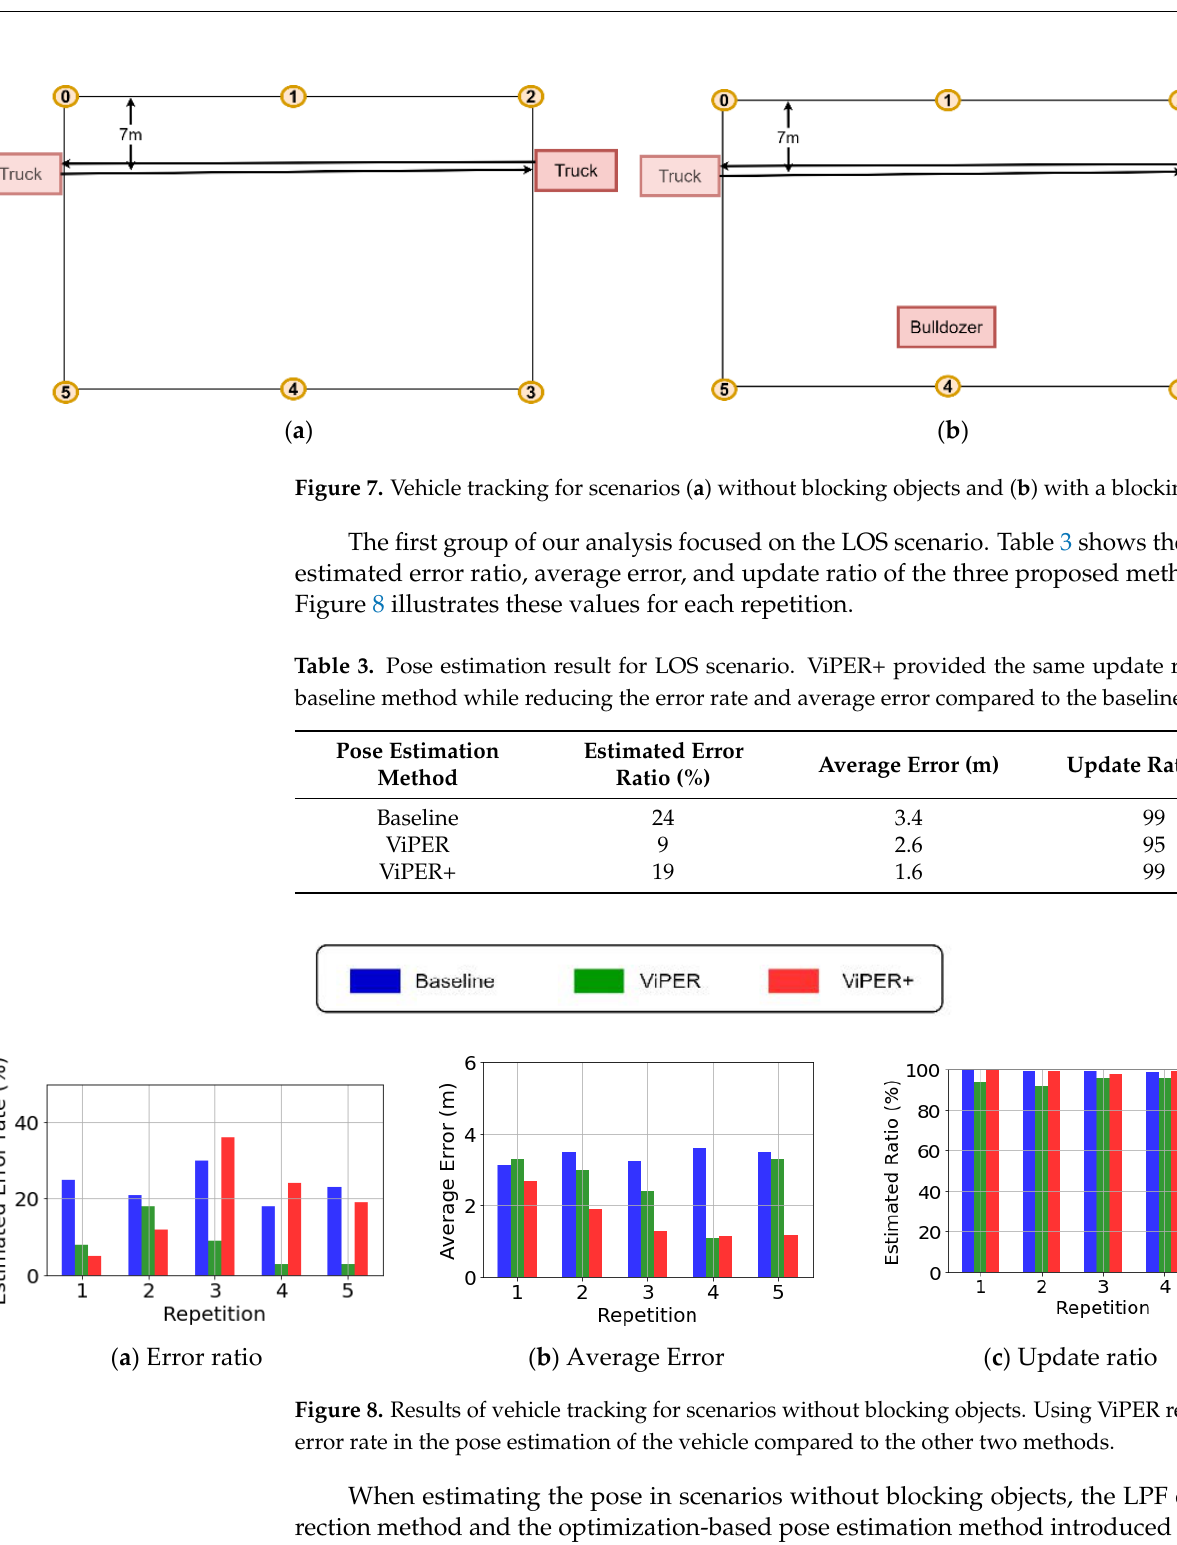
Figure 6. Tag placement for vehicle pose estimation.